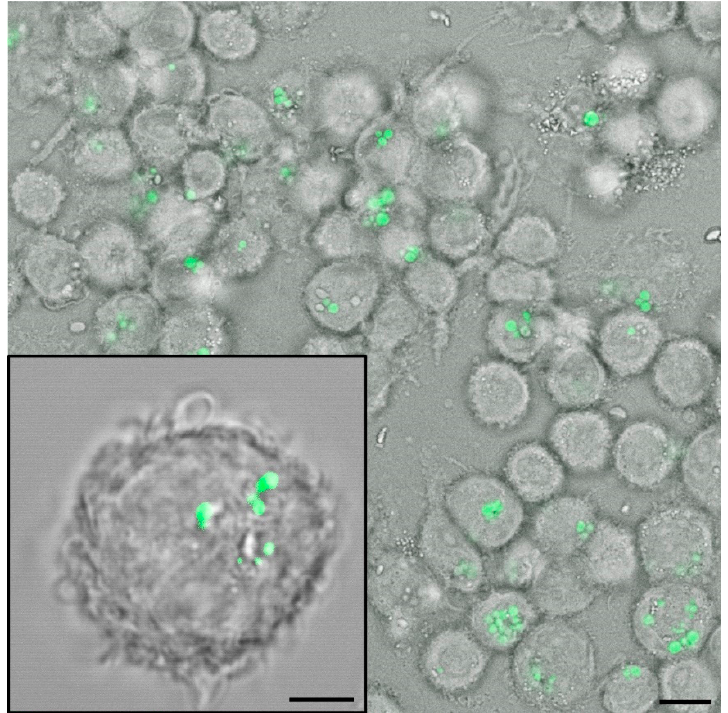
Figure 3. Uptake of zein-green fluorescent protein (GFP) bodies into antigen presenting cells, as described in Schwestka et al. 2020 [89]. Upon 2 h of incubation, zein-GFP protein bodies (green) are taken up by U937 cells. Inset shows an enlarged confocal image of a cell. Bars represent 10 µm.